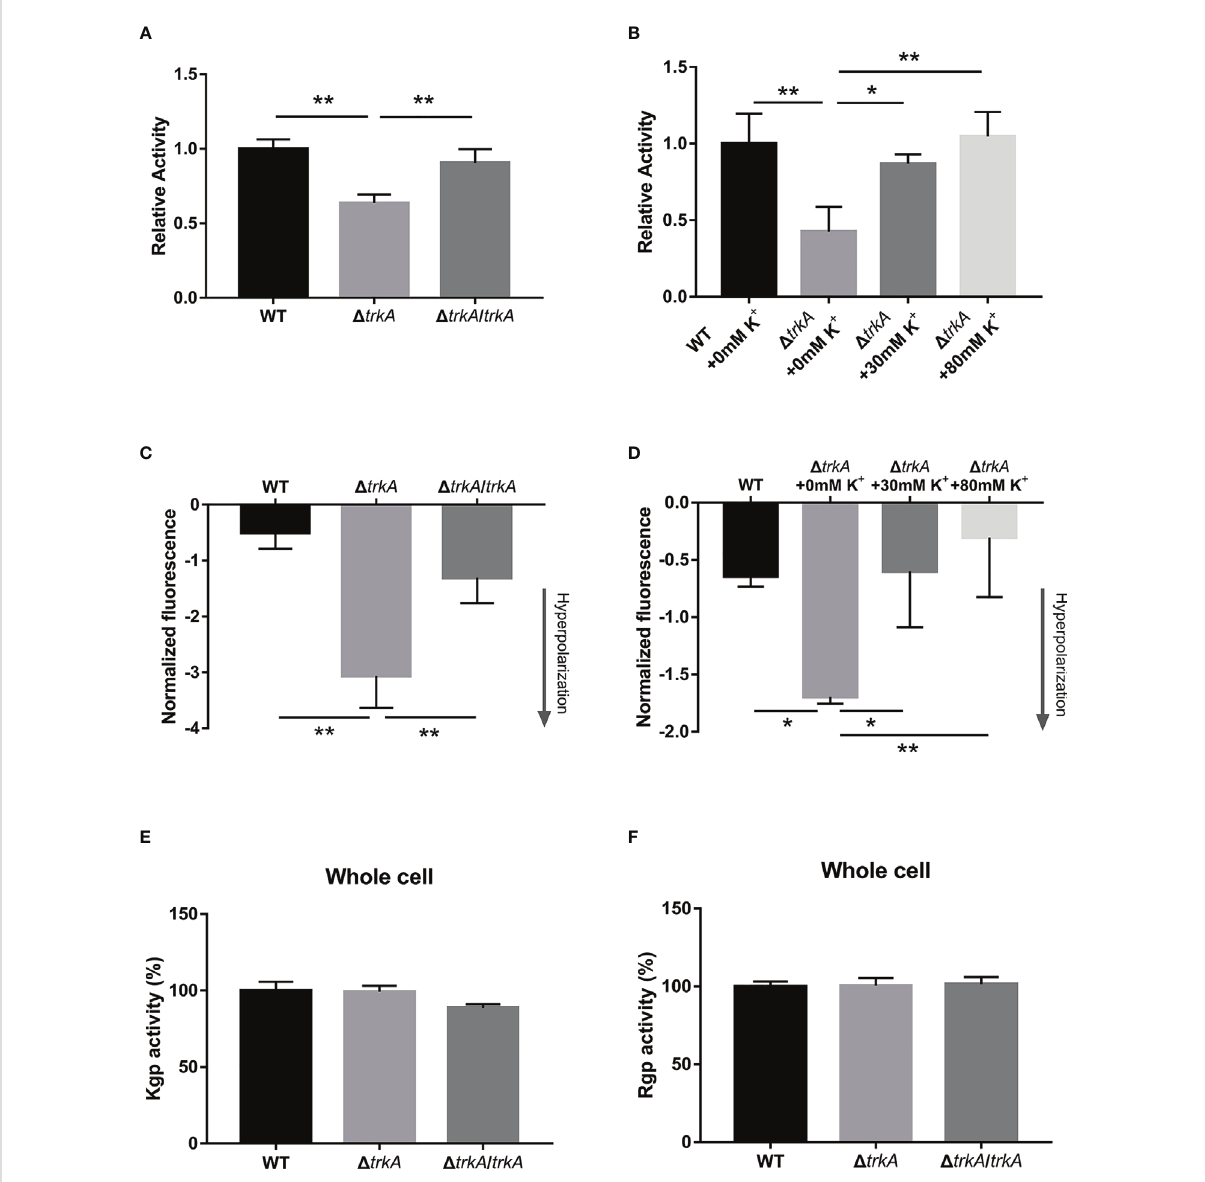
FIGURE 3 Loss of trkA leads to membrane potential-related hemolysis activity alteration. (A, B) Hemolytic assay, (C, D) membrane potential determination, and (E, F) Kgp and Rgp activities of Porphyromonas gingivalis WT, D trkA , and D trkA / trkA strains. N = 3, * p < 0.05, ** p <